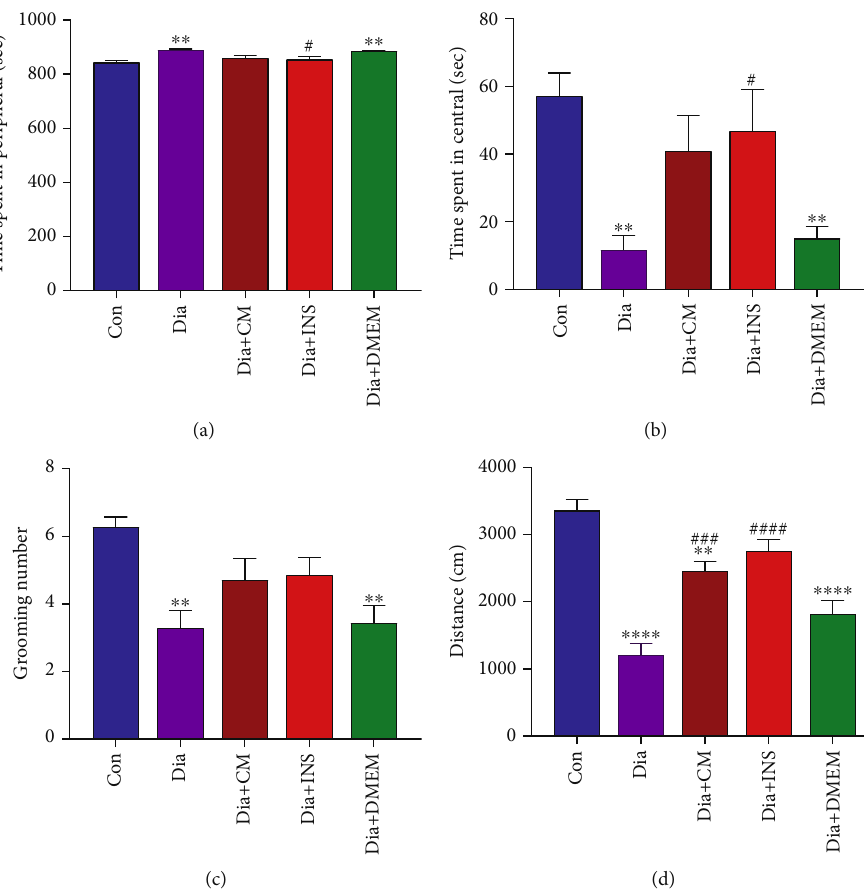
Figure 5: E ff ects of WJMSC-CM and insulin on anxiety-like behaviors in open fi eld tasks in diabetic rats. Compared to the untreated diabetic group, one-way ANOVA analysis demonstrated a decrease in peripheral time (a) and an increase in central time (b) in WJMSC- CM- and insulin-treated diabetic rats, but only signi fi cant in the Dia +INS group. The grooming number was restored to the control level in both Dia +CM and Dia+ INS groups (c). The administration of WJMSC-CM and insulin signi fi cantly increased the total distance traveled (d) in WJMSC-CM- and insulin-treated diabetic groups. The values are presented as mean ± SEM ( n = 7 ). Signi fi cant di ff erences versus the control ( ∗∗ P < 0 : 01 , ∗∗∗∗ P < 0 : 0001 ) and diabetes rats ( # P < 0 : 05 , ### P < 0 : 001 , #### P < 0 : 0001 ). Con: control; Dia: diabetes; Dia +CM: WJMSC-CM-treated diabetic group; Dia+ INS: insulin-treated diabetic group; Dia + DMEM: DMEM-treated diabetic